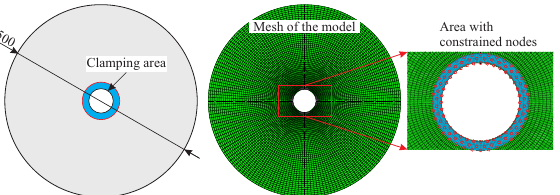
Figure 1. A schematic illustration of the rotor geometry is shown on the left. In the middle, the gen- erated FE-mesh is presented with one element in the thickness direction and an approximate element thickness of 5mm. On the right, the boundary conditions are illustrated.